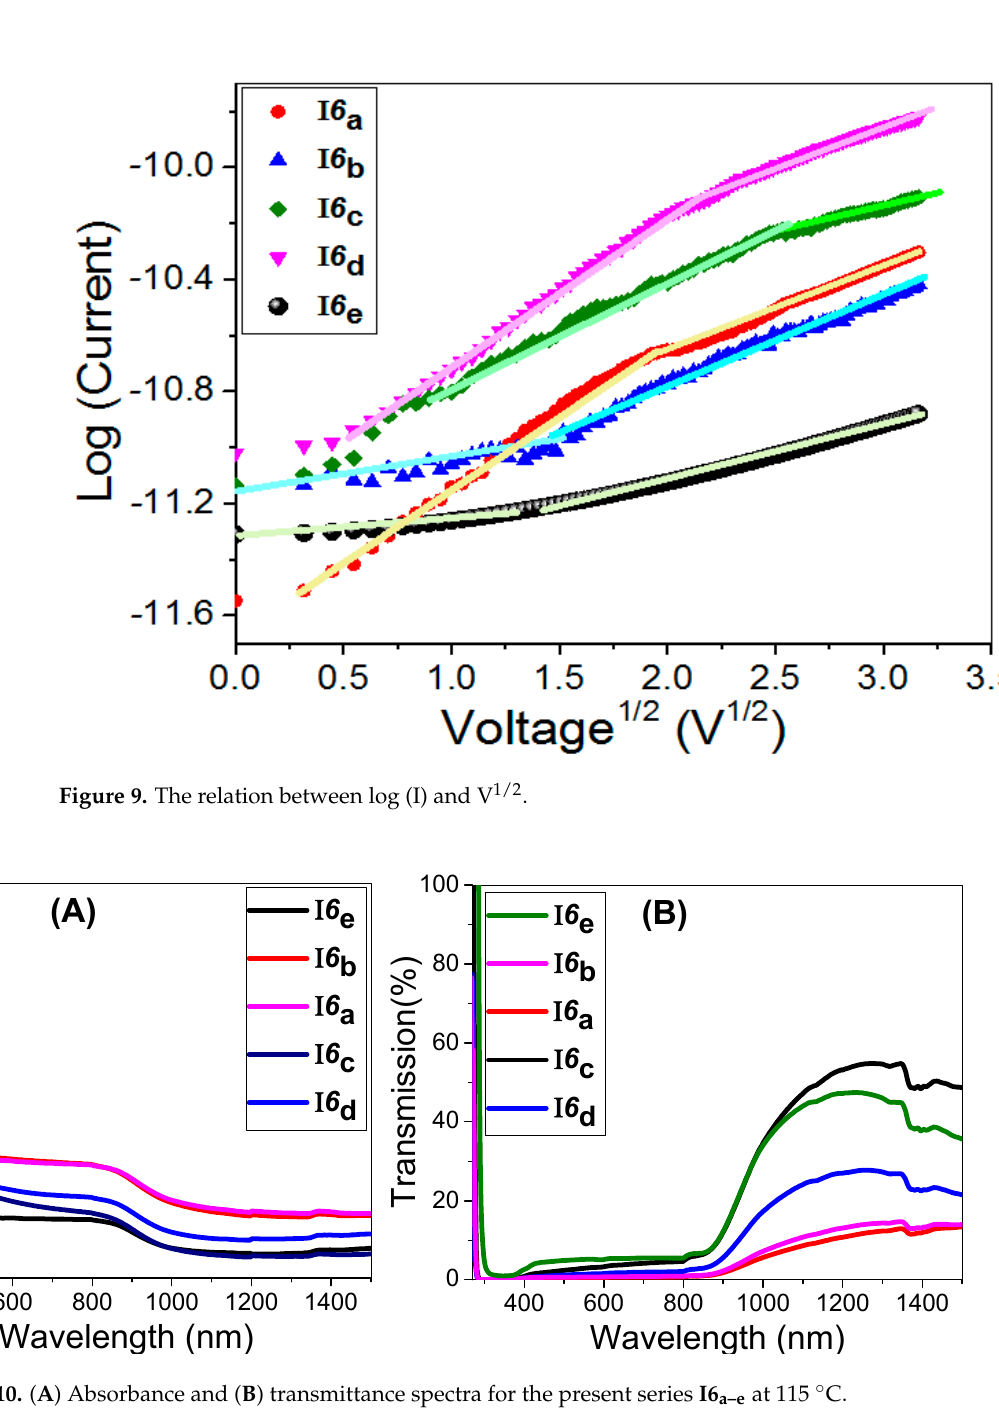
where h is the Planck’s constant (6.625 × 10 − 34 J/s), A is a constant, and E g is the optical bandgap. The values of direct E g for the prepared I6 a–e films are obtained by extrapolating the linear portions of the plot of ( α · h ν ) 2 vs. h ν to α = 0 as shown in Figure 11A.